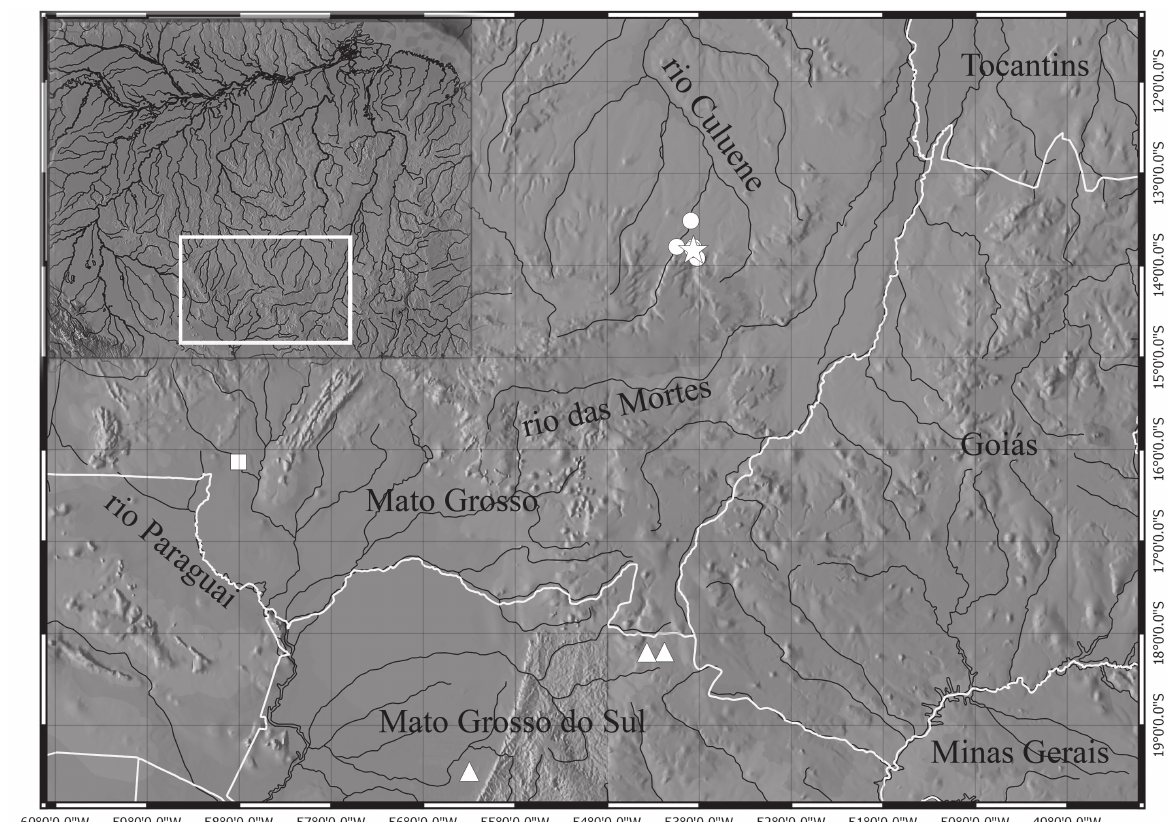
Fig. 4 . Distribution of Farlowella gianetii in the upper rio Xingu basin and Farlowella jauruensis in the upper rio Paraguai basin. Symbols represent the type-locality of F. gianetii (star) and F. jauruensis (square), along with additional specimens of F. gianetii (spots) and F. jauruensis (triangles). Major rivers are indicated in the